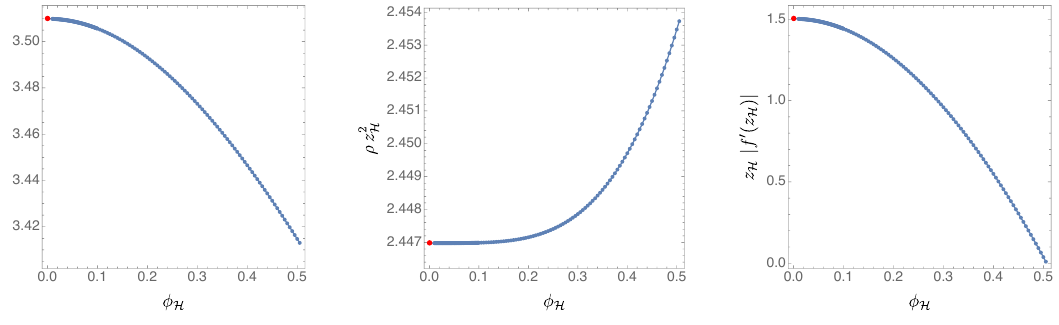
Figure 3 . Nonlinearly smooth Cauchy horizons as a function of the scalar (cid:12)eld at z H . Left: mass m of the scalar (cid:12)eld, middle: charge density (cid:26) , right: z H j f 0 ( z H ) j . All plots were generated while keeping (cid:24) = 1 : 448. The red disks were obtained by solving the linear problem. tidal force singularities, and found none. We have chosen many other values of (cid:24) , and the overall behaviour appears